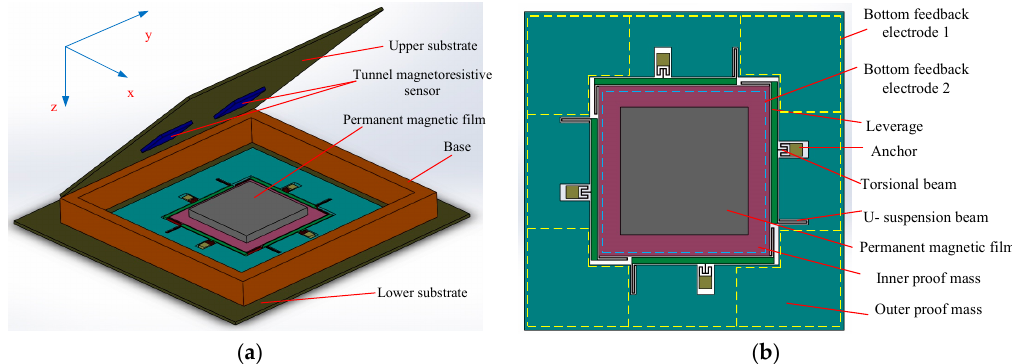
Figure 1. Structural schematic of the micromachined z-axis tunnel magnetoresistive accelerometer: ( a ) The structure layout of tunnel magnetoresistive accelerometer; ( b ) The plane main structure of tunnel magnetoresistive accelerometer.